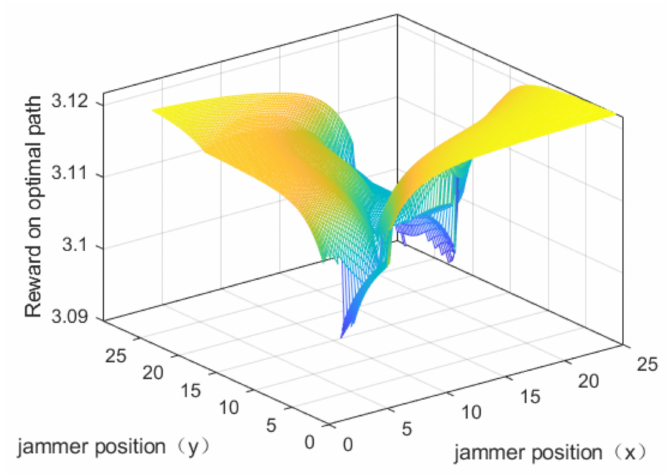
Figure 5. Influence of different jammer positions on optimal path return.